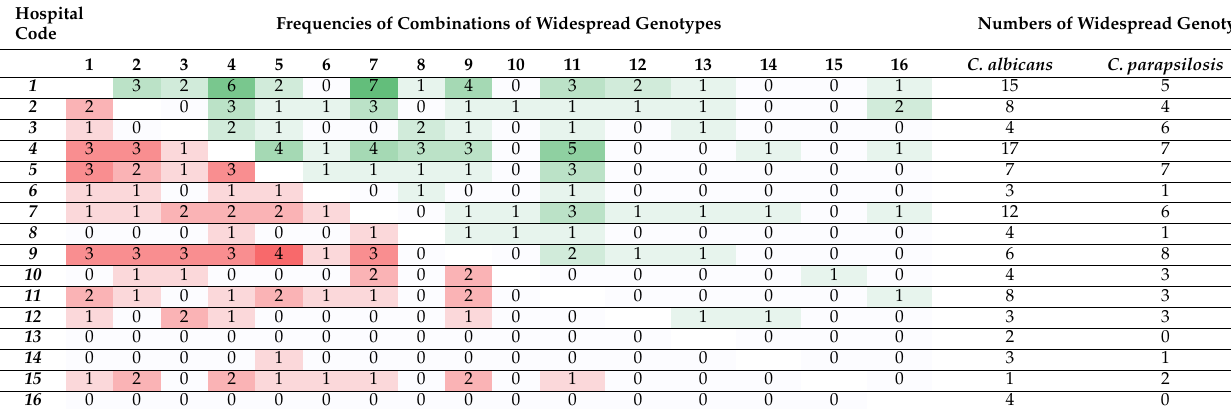
Table 3. Distribution of widespread clusters of C. albicans (green shades) and C. parapsilosis (pink shades) among the participant hospitals.